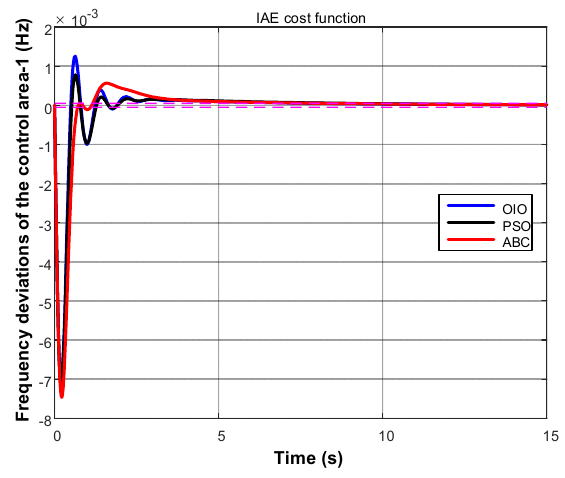
Figure 4. Change in frequency of area ‐ 1 for IAE. Energies 2017 , 10 , 2134